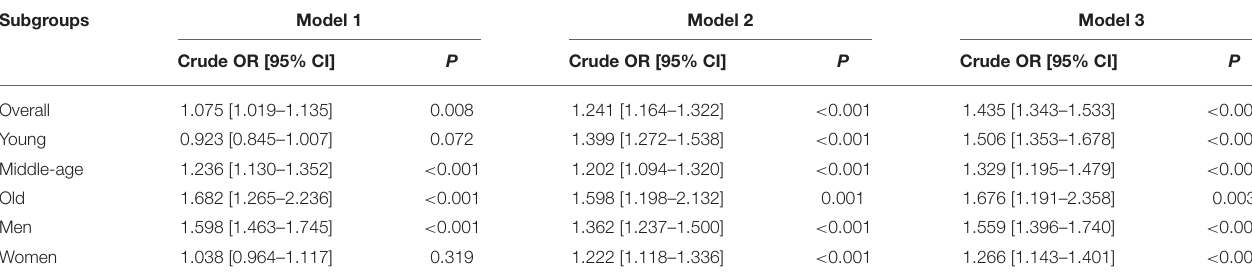
TABLE 3 | Low skeletal muscle mass associated with odds ratio for arteriosclerosis using logistic regression analysis in overall subjects and subgroups.